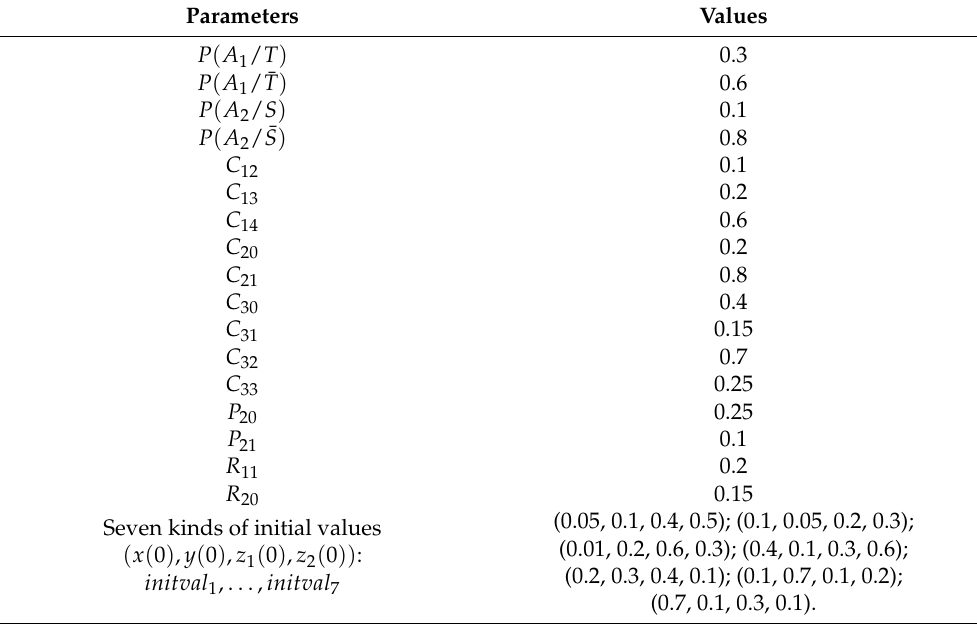
Table 5. List of parameter values used in the numerical results. Parameters